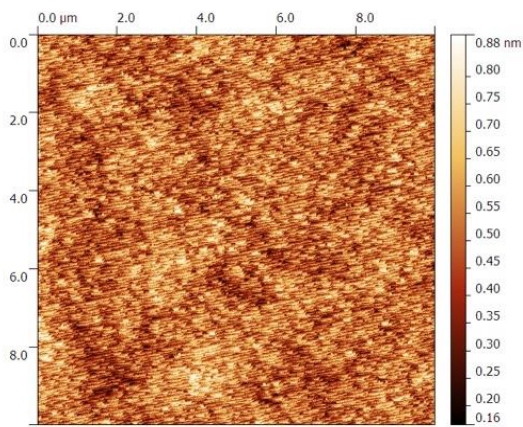
Figure 5. 10 × 10 mm 2 atomic force microscopy (AFM) scan of an InAs/InAsSb T2SL sample. Clear monolayer steps can be observed.